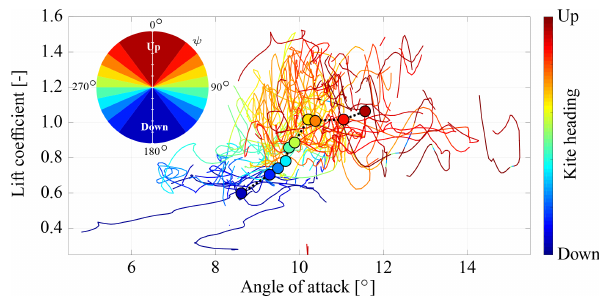
Figure 19. Measured lift coefficient C L of the kite as a function of the angle of attack, α , colored by the